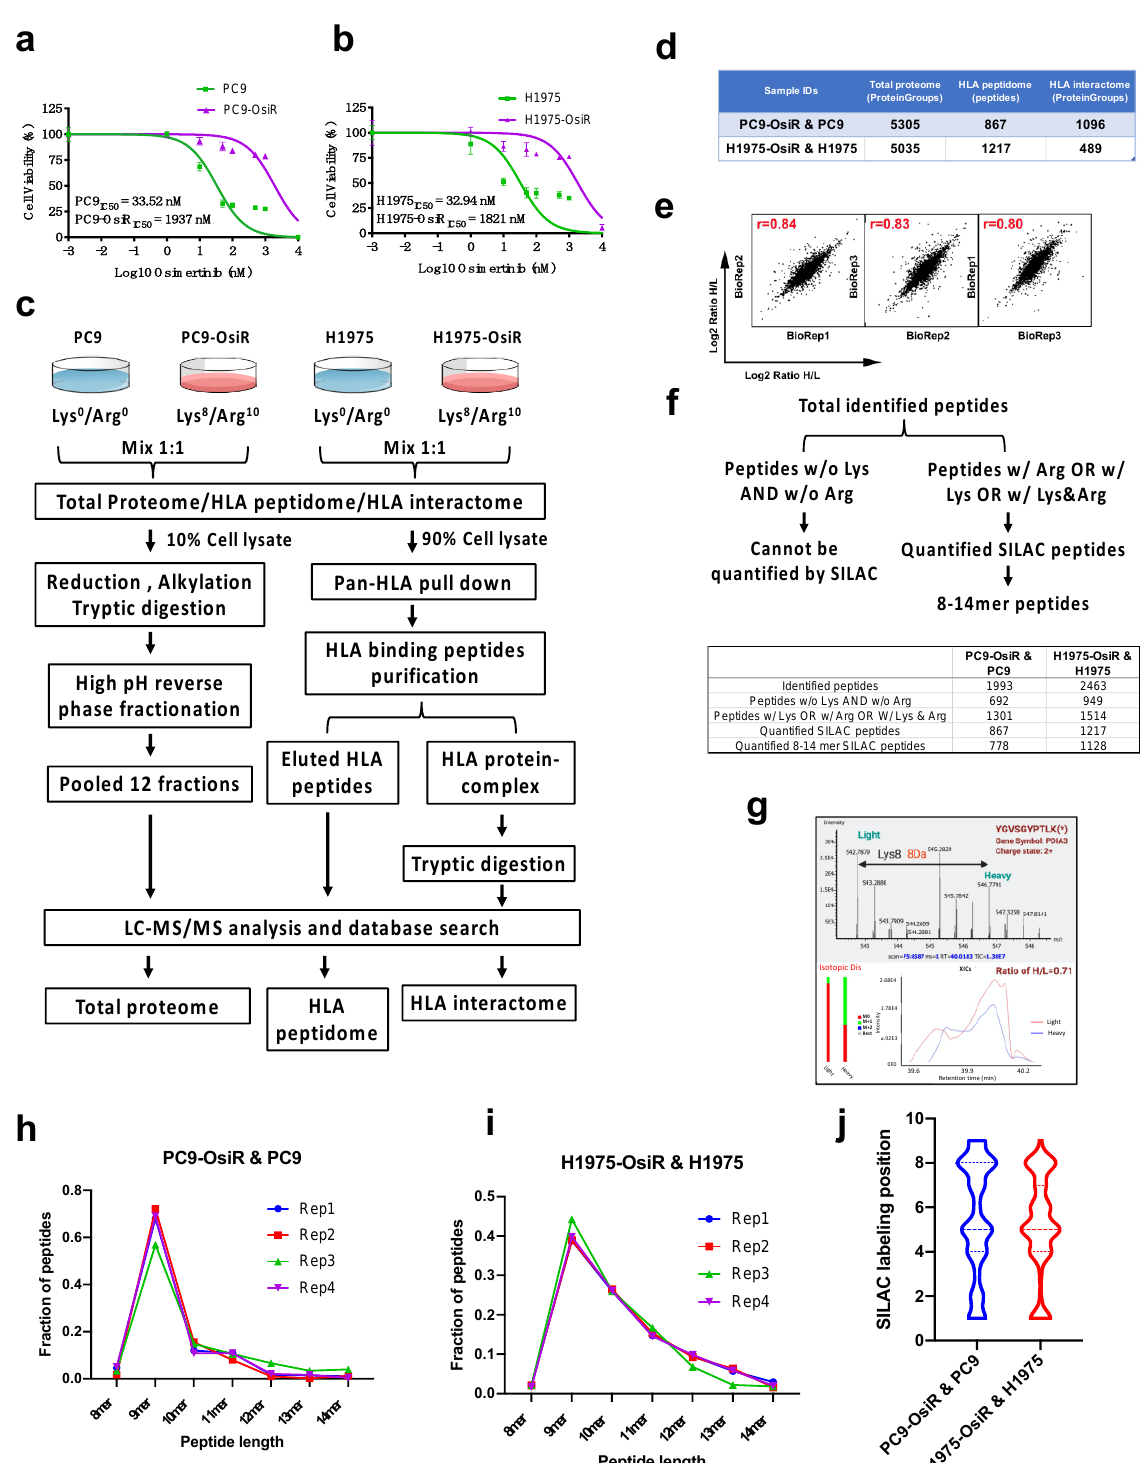
Figure 1. SILAC-based quantitative proteomic profiling of HLA class I-associated peptides. ( a , b ) Cell viability assay of PC9 and PC9-OisR ( a ) and H1975 and H1975-OsiR ( b ) under a serial concentration of osimertinib (0.001~10000 nM). ( c ) Schematic workflow of SILAC-based quantitative proteomic analysis of total proteome, HLA immunopeptidome and HLA interactome in PC9-OsiR/PC9 and H1975-OsiR/H1975 EGFR mutant lung adenocarcinoma cells. ( d ) Summary table of total identifications of whole-cell proteome, HLA peptidome and HLA interactome. ( e ) Representative example of correlation analysis among biological replicates; correlation analysis of total proteome of PC9-OsiR/PC9 is shown. ( f ) Schematic of discovery pipeline of SILAC quantified HLA class I-presented peptides (upper panel) and summary table of the